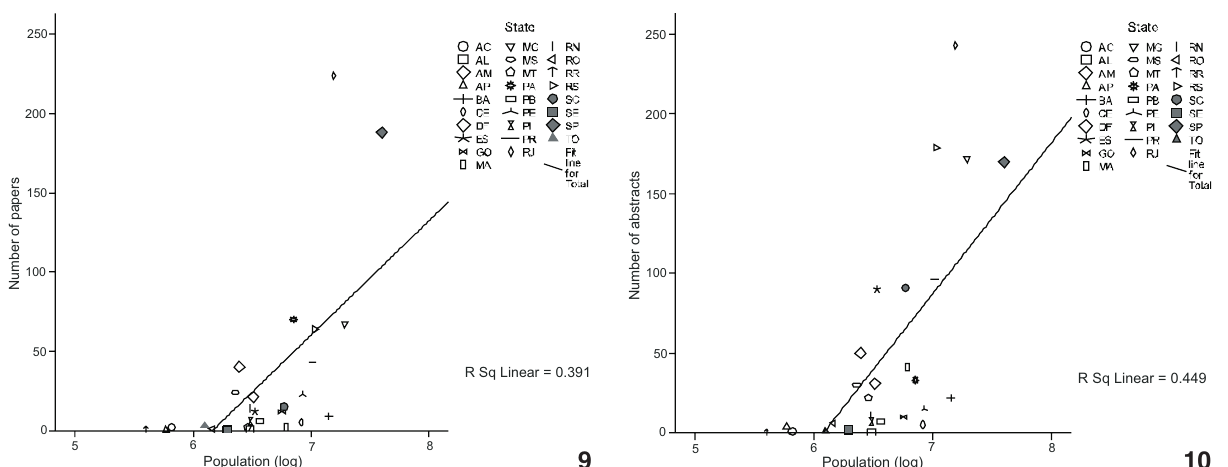
Figures 9-10 Relationship between the population size (log) and the number of papers (9) and abstracts (10) in each Brazilian state between 2000 and